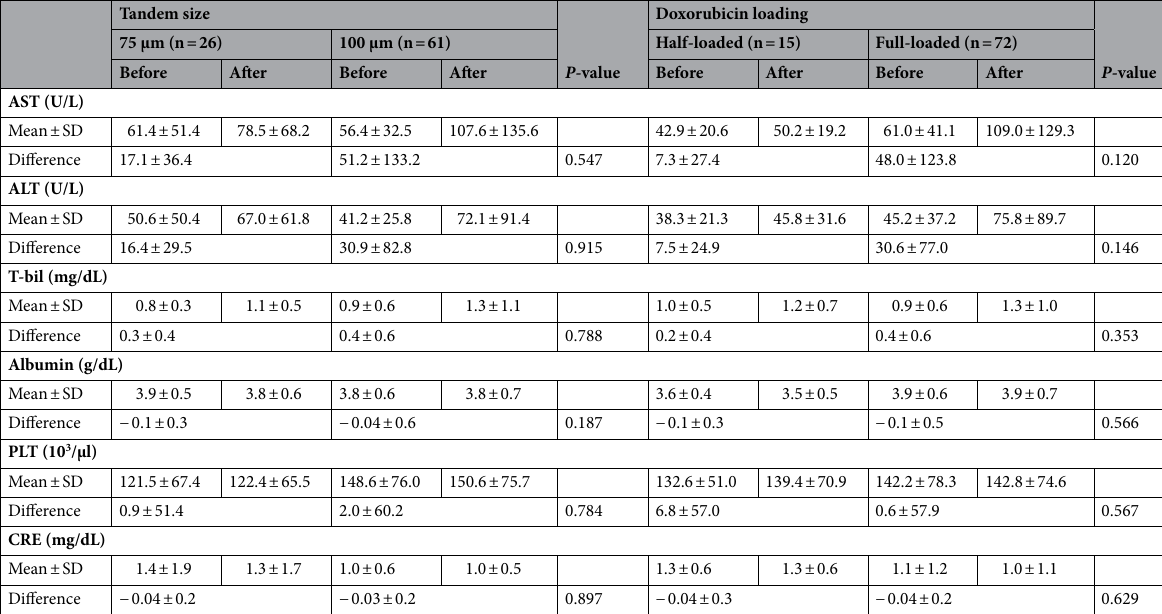
Table 2. Deflection of biochemical indices in HCC patients (n = 87). Mann–Whitney test used to compare changes of values from baseline between different TANDEM size or different doxorubicin-loading dose. AST aspartate aminotransferase, ALT alanine aminotransferase, T-bil Total bilirubin, PLT platelet, CRE creatinine.